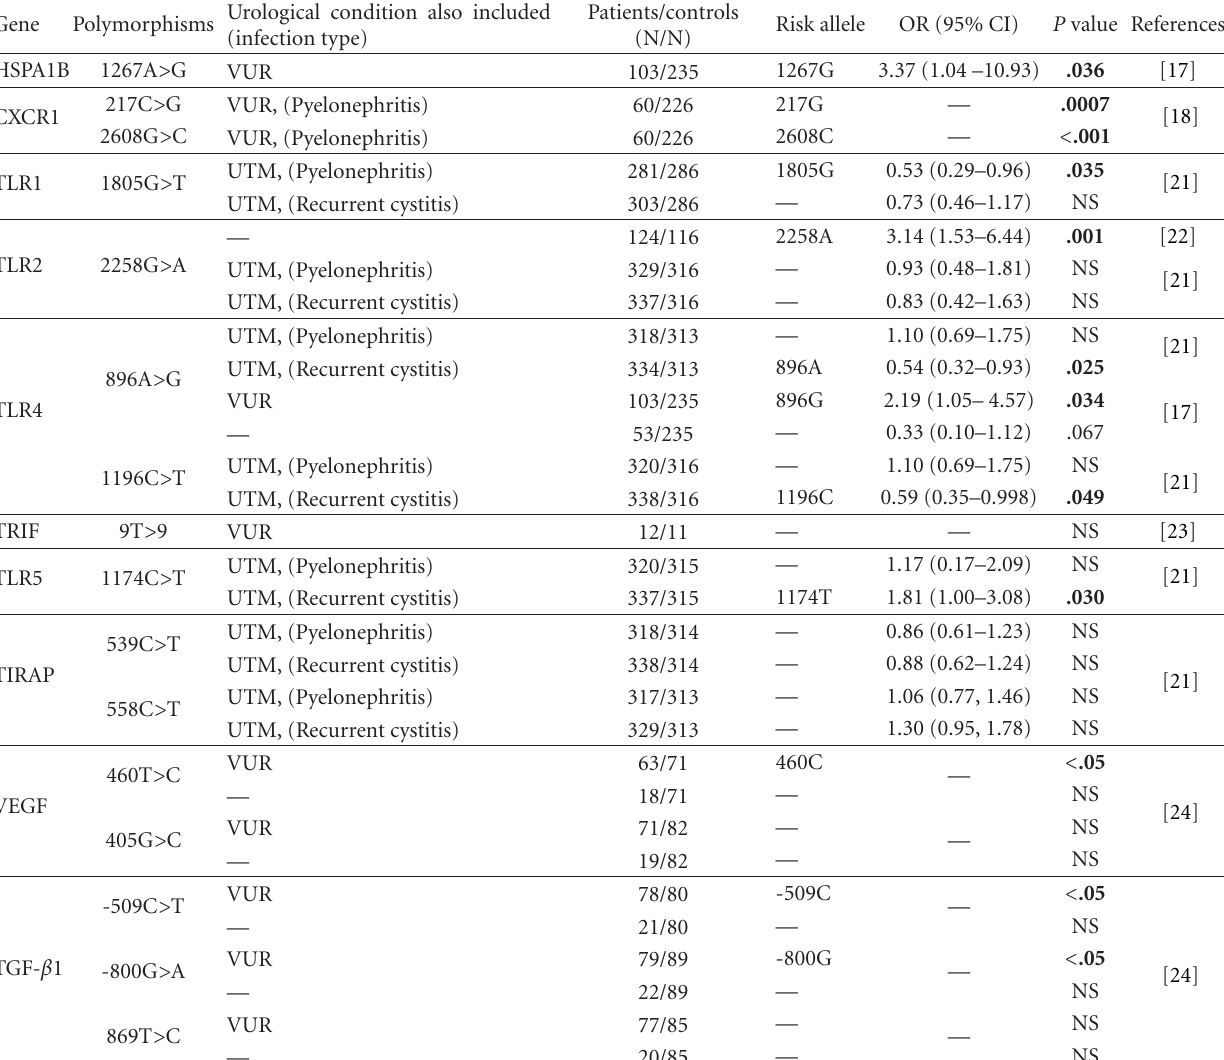
Table 2: Comparison of the genotype frequencies for each polymorphism studied in patients with recurrent urinary tract infection and in controls. (CXCR: IL-8 receptor; HSPA1B: Heat shock protein 72; NS: not significant; PS: pyelonephritis; TGF: Transforming growth factor; TIRAP: TIR domain-containing adapter protein; TLR: Toll-like receptor; UTM: urinary tract malformations; VEGF: Vascular endothelial growth